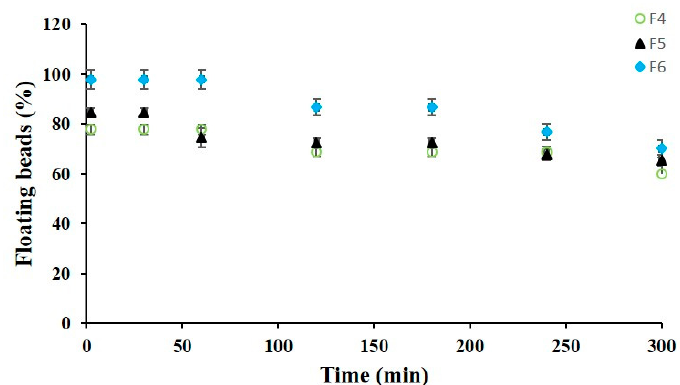
Figure 3. Floating percentages of #F4, #F5, and #F6 in simulated gastric fluid (SGF).